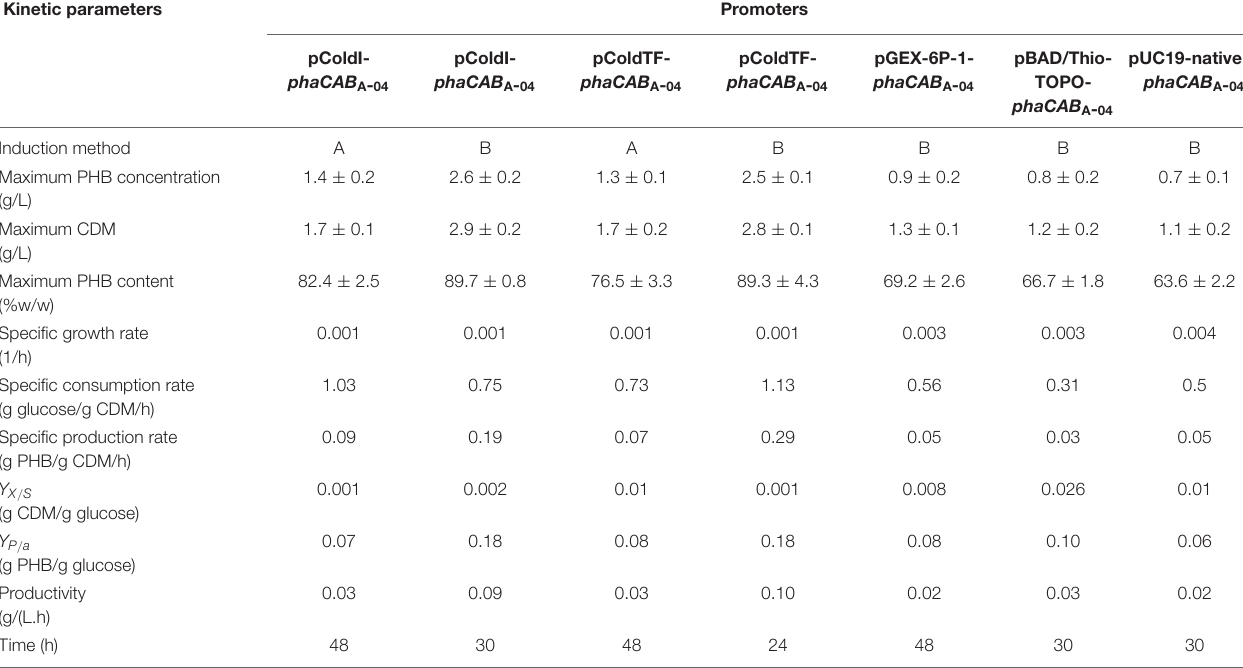
(g PHB/g-glucose), and PHB production g/(L . h) by C. necator strain A-04, E. coli JM109 (pColdI- phaCAB A - 04 TABLE 4 | Comparison of the kinetics of cell growth, Y P S